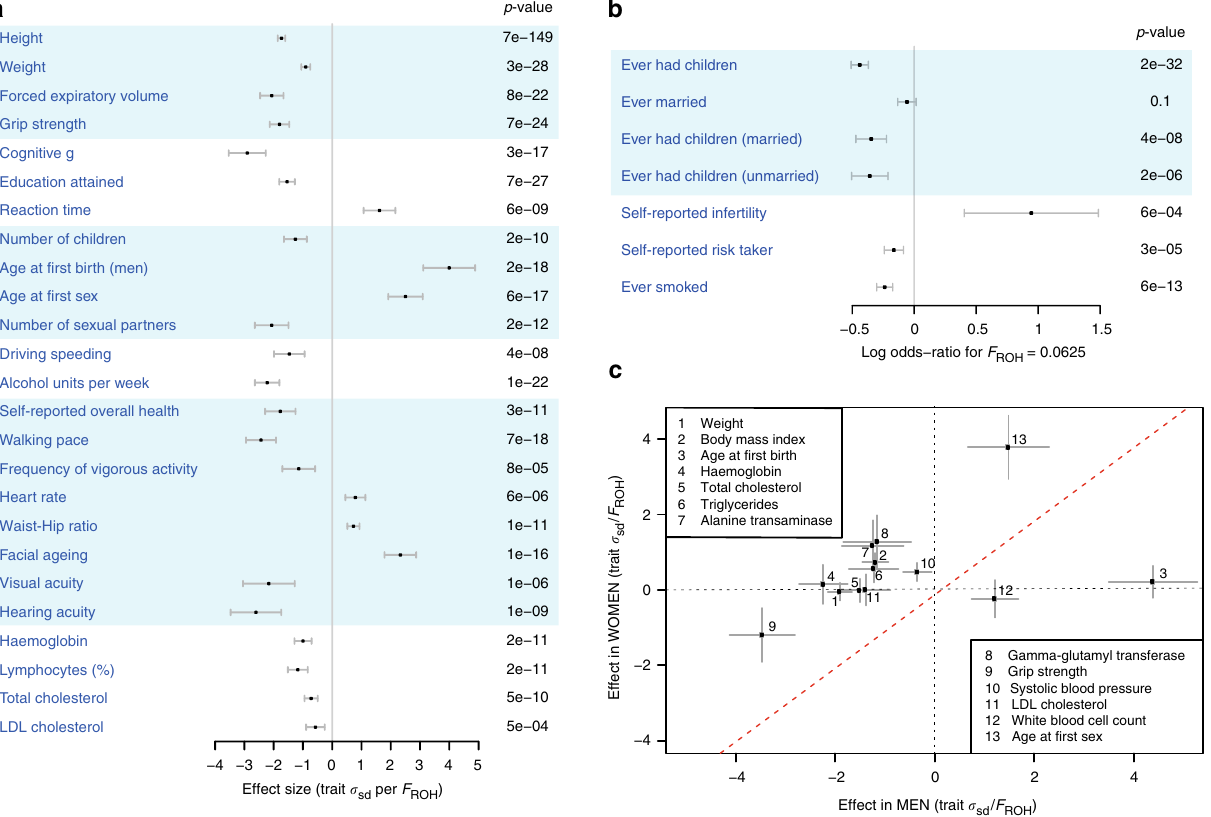
Fig. 3 Scope of inbreeding depression. a Effect of F ROH on 25 quantitative traits. To facilitate comparison between traits, effect estimates are presented in units of within-sex standard deviations. Traits shown here reached Bonferroni-corrected signi fi cance of p = 0.0005 ( = 0.05/100 traits). Sample sizes, within-sex standard deviations, and effect estimates in measurement units are shown in Supplementary Data 9. FEV1 forced expiratory volume in one second. Traits are grouped by type. b Effect of F ROH on eight binary traits with associated p values. Effect estimates are reported as ln(Odds-Ratio) for the offspring of fi rst cousins, for which E ( F ROH ) = 0.0625. Self-declared infertility is shown for information, although this trait does not reach Bonferroni corrected signi fi cant ( OR 0 : 0625 = 2.6 ± 1.1, p = 0.0006). Numbers of cases and controls and effect estimates for all binary traits are shown